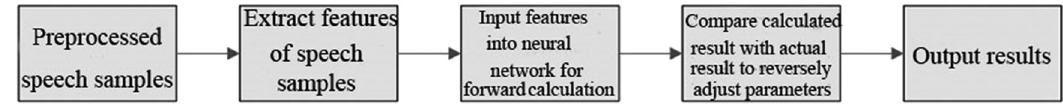
Figure 1: The basic fl ow of speech